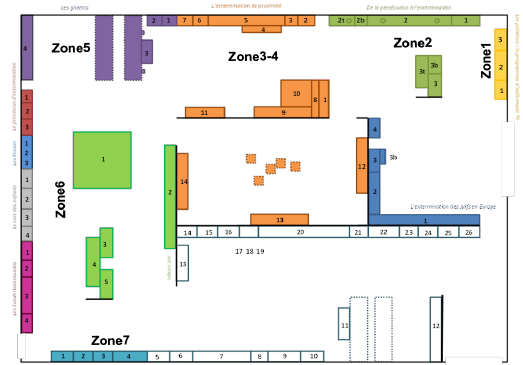
Figure 1. Plan of the "Genocide and mass violence" room. The details of each element are in the plan is in